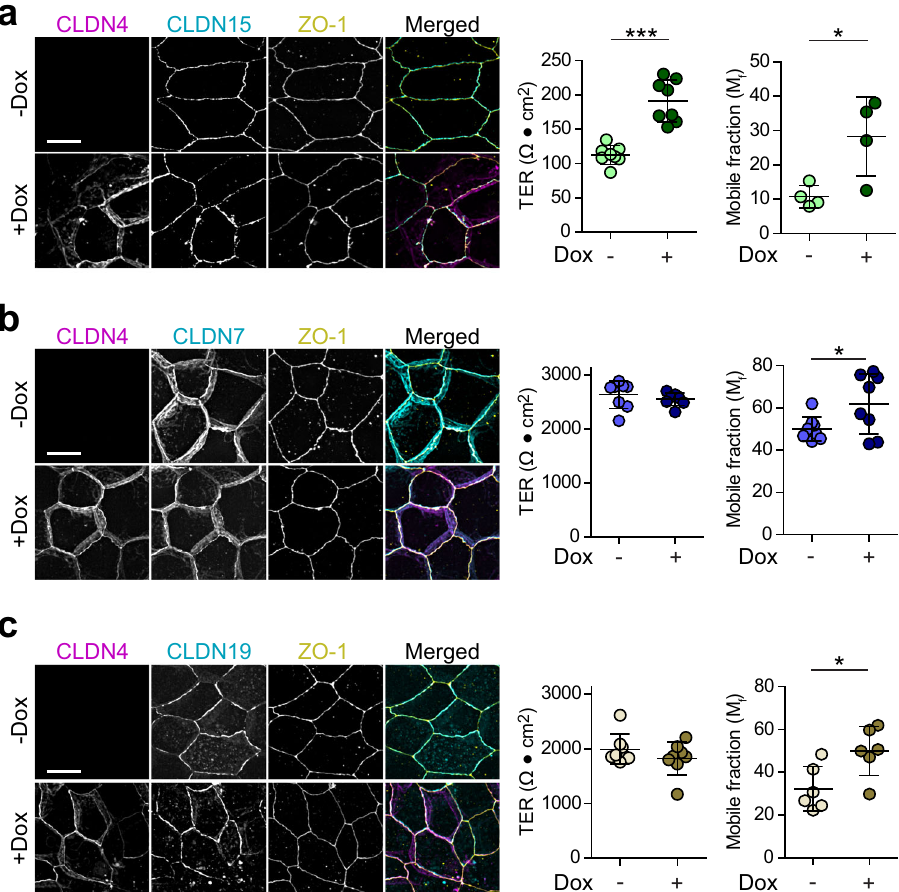
Fig. 4 Claudin-4 reduces paracellular conductance across claudin-15, but not claudin-7 or claudin-19, channels. a Maximum projection images of MDCK I C4KO monolayers with constitutive expression of EGFP-claudin-15 (cyan in merged image) without ( − Dox, light green symbols) or with ( + Dox, dark green symbols) mCherry-claudin-4 expression. ZO-1 immunostaining is shown for reference. Merged images show claudin-15 (cyan), claudin-4 (magenta) and ZO-1 (yellow). TER of monolayers expressing EGFP-claudin-15 is low, similar to EGFP-claudin-2-expressing monolayers and is markedly increased by expression of mCherry-claudin-4 ( + Dox). FRAP analysis shows that the mobile fraction of EGFP-claudin-15 is increased by mCherry-claudin-4 expression. n = 8 (TER) and 8 (FRAP), respectively, representative of 3 independent experiments. Two-tail unpaired t -test. * P = 0.021; *** P < 0.0001. Scale: 10 µ m. b Maximum projection images, TER, and FRAP analysis of MDCK I C4KO monolayers with constitutive expression of EGFP-claudin-7 without ( − Dox, light blue symbols) or with ( + Dox, dark blue symbols) mCherry-claudin-4 expression. Merged images show claudin-7 (cyan), claudin-4 (magenta) and ZO-1 (yellow). Claudin-4 expression does not change TER of claudin-7-expressing cells but increases the claudin-7 mobile fraction. n = 8 (TER) and 8 (FRAP), respectively, representative of 3 independent experiments. Two-tail unpaired t -test. * P = 0.047 (FRAP). Scale: 10 µ m. c Maximum projection images, TER, and FRAP analyses of MDCK I C4KO monolayers with constitutive EGFP-claudin-19 expression without ( − Dox, light brown symbols) or with ( + Dox, dark brown symbols) mCherry-claudin-4 expression. Merged images show claudin-19 (cyan), claudin-4 (magenta) and ZO-1 (yellow). Scale: 10 µ m. Claudin-4 does not affect TER of claudin-19-expressing cells but does induce a small increase in the claudin-19 mobile fraction. n = 8 (TER) and 6 (FRAP), respectively, representative of 3 independent experiments. Two-tail unpaired t -test. * P = 0.019 (FRAP). Scale: 10 µ m. Data are presented as mean ± SD